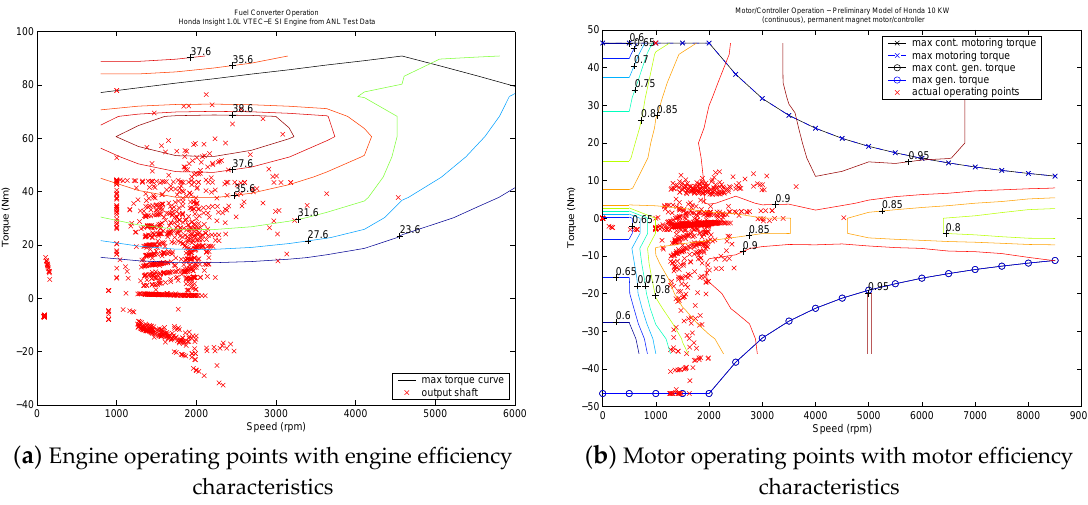
Figure 7. Torque-speed operating points of engine and motor using the PEACS EMS.